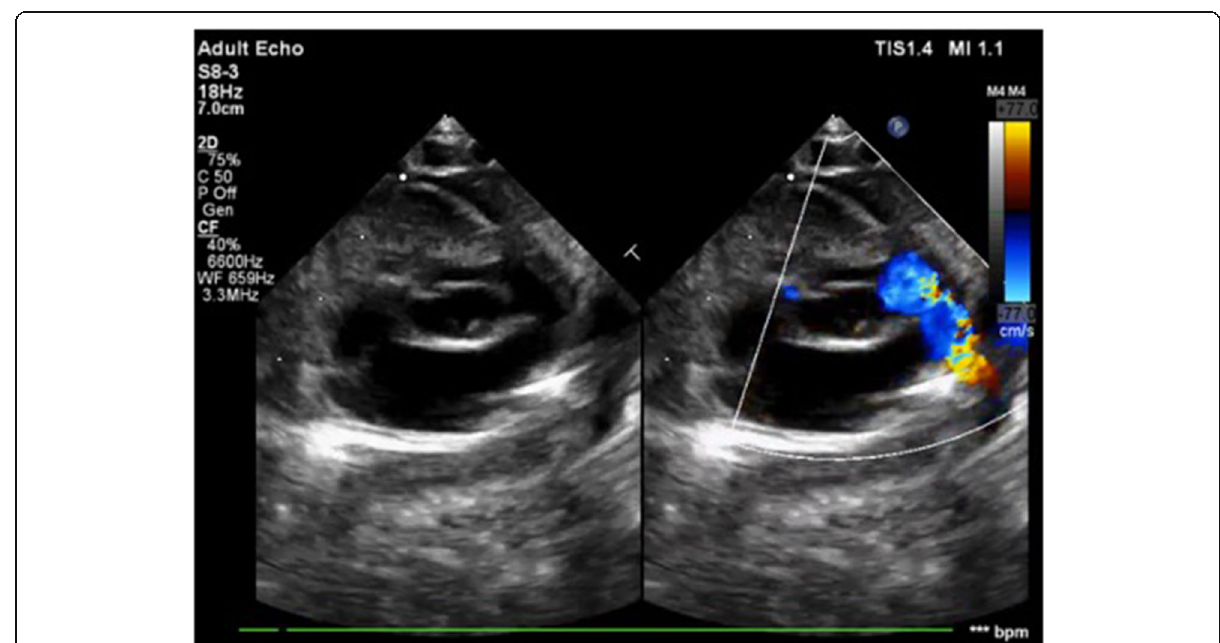
Fig. 3 Post-procedure echocardiogram showing good antegrade flow across the pulmonary